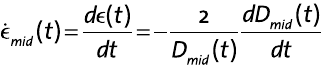
Figure 1: Schematic of the FiSER. The top plate separates exponentially from the bot- tom plate to create a nomi- nally constant strain rate in the elongating sample. The diameter of the sample is measured at the mid-plane using a laser, while a sta- tionary force transducer on the bottom plate measures the tensile force in the stretching column. Figure 2: Schematic of the Sentmanat Extensional Rheometer. Sample is stretched between two counter rotating cylin- drical